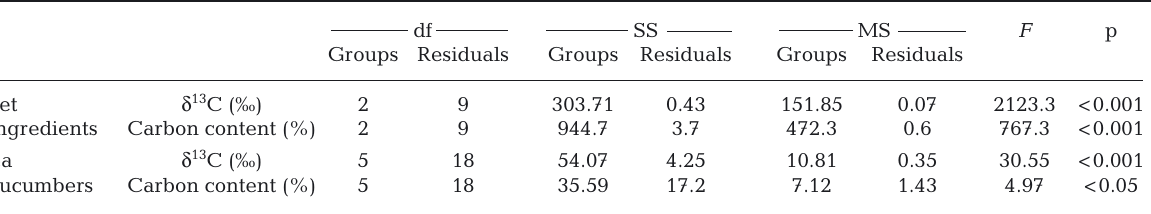
Table 5. Results of ANOVA for δ 13 C and carbon content of 3 ingredients, and sea cucumbers at the beginning and end of